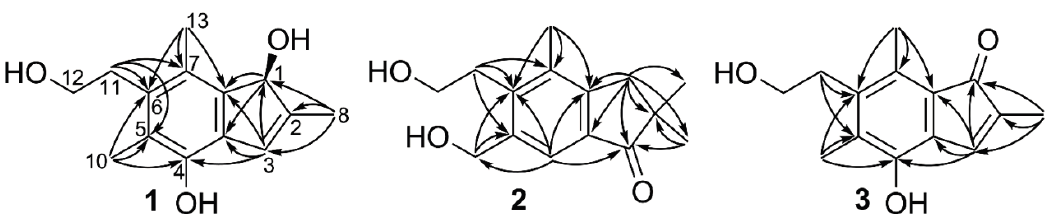
Figure 2. Diagnostic HMBC NMR correlations of compounds 1 – 3 used for structure determination. The HMBC data was obtained in MeOH- d